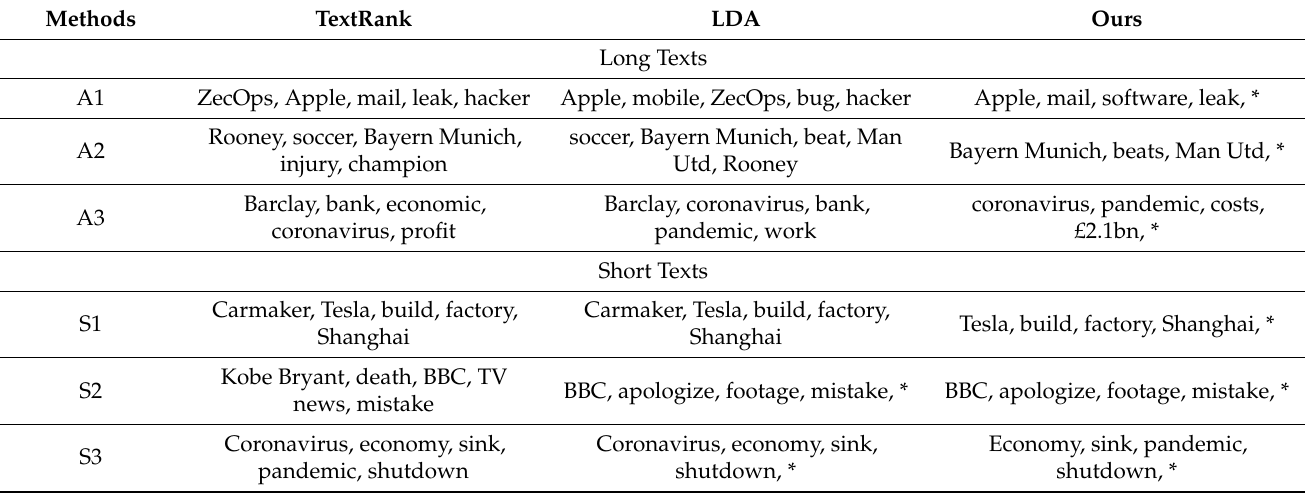
Table 3. The extracted words from the sampled texts (* marks that less than five words can be